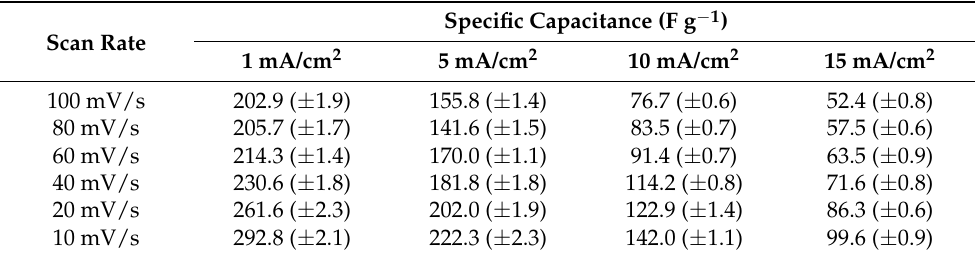
Table 1. The specific capacitance of MnO 2 /graphene/Ni foam at different scanning rates under different current